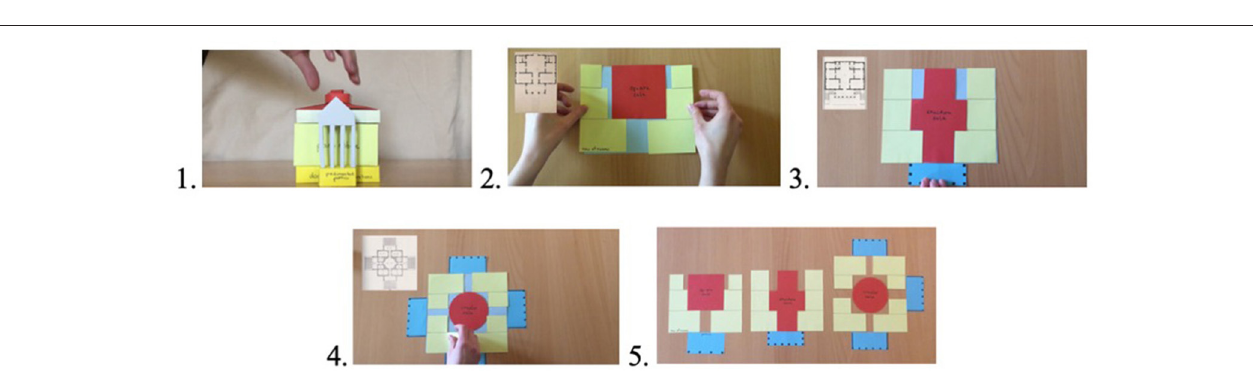
FIGURE 5 | Two interventions into the same model (Student G).